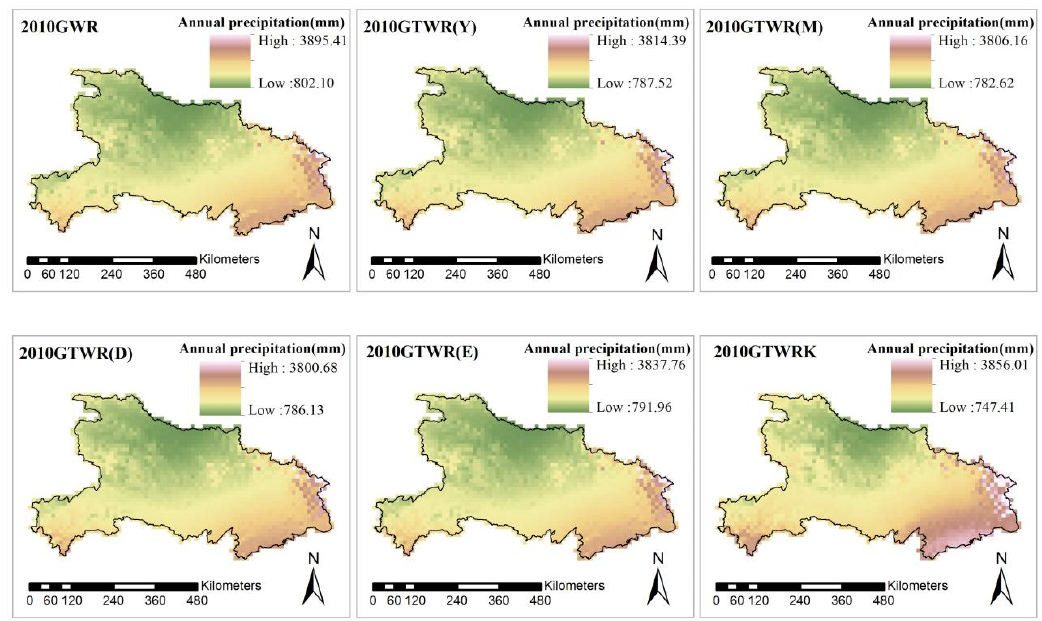
Figure 8. The interpolation distribution maps for GWR, GTWR(Y), GTWR(M), GTWR(D), and GTWR(E) corresponding to 2010.